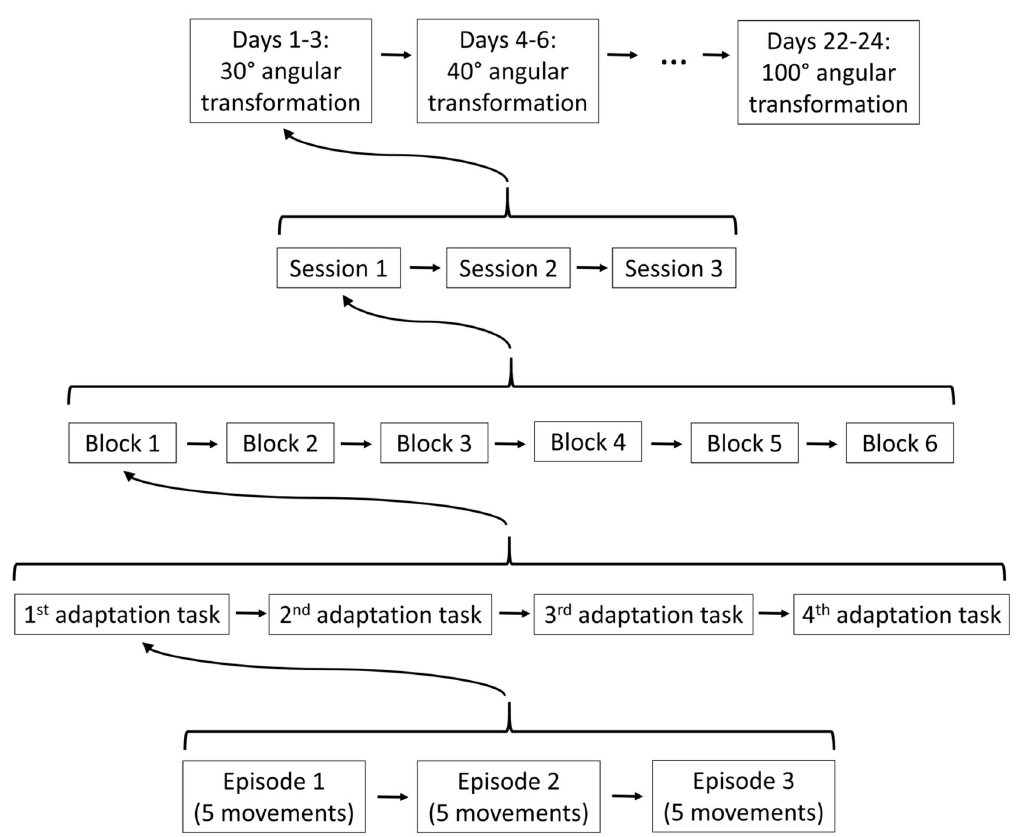
Fig 2. Experimental design. The participants of the intervention group trained for three episodes of five movements a first adaptation task, then trained for three episodes a second adaptation task and so on. The four adaptation tasks were practiced in six blocks, which constituted one session. One to three days later, they performed the next training session. Three sessions were trained with a given angular transformation before it increased by